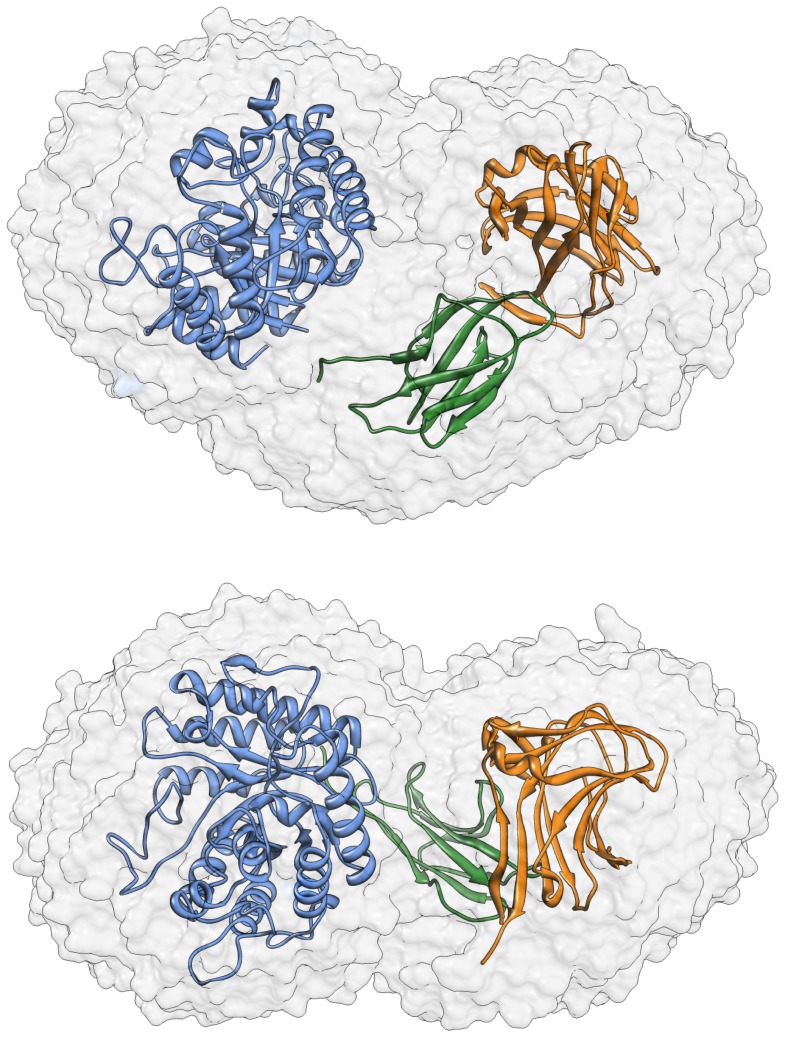
EOM model.Selected model (cartoon) having the highest frequency in the optimized population superposed to the cloud of models. The structure shown is rotated 90°about the long axis of the structure to produce the two views.